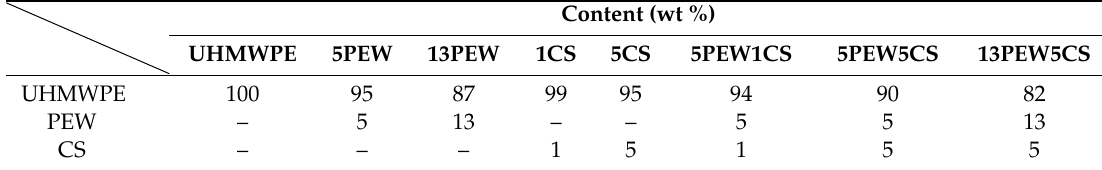
Table 1. The formulation of ultra-high-molecular-weight polyethylene (UHMWPE) / polyethylene wax (PEW) / calcium stearate (CS) materials. Content (wt %) UHMWPE 5PEW 13PEW